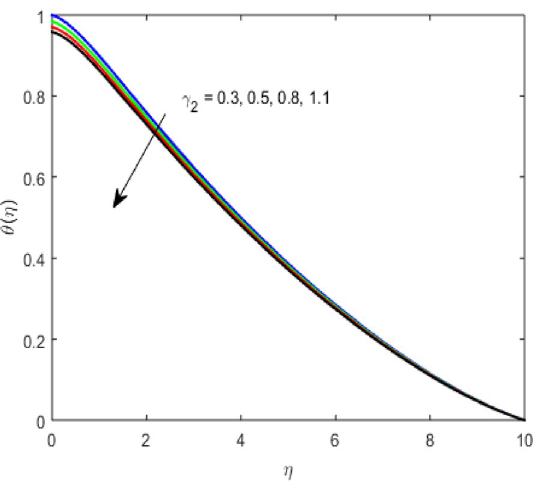
Figure 12. Temperature distribution for varying γ 2